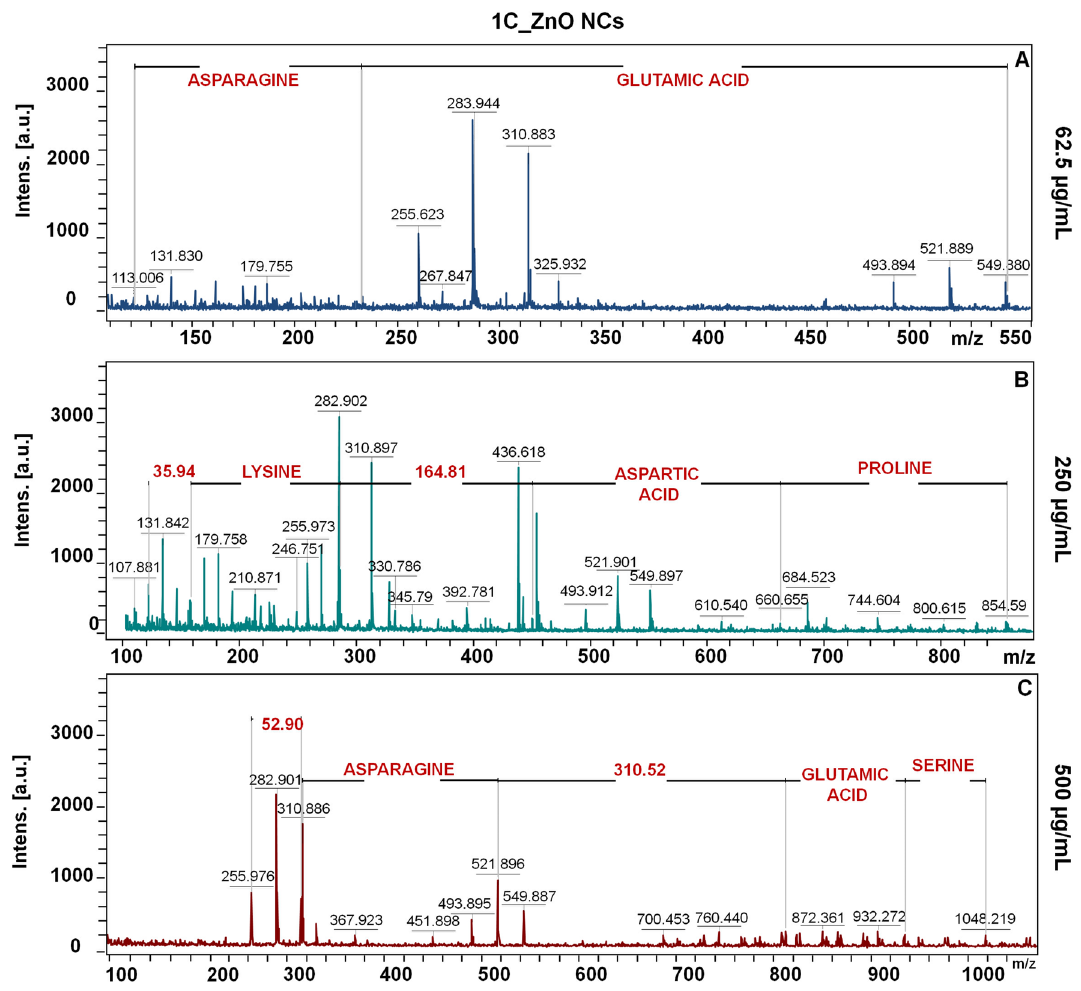
Figure 6. The LDI-TOF-MS spectra for core–shell signals of 1C_ZnO NCs at 62.6 ( A ), 250 ( B ) and 500 ( C ) µg/ mL